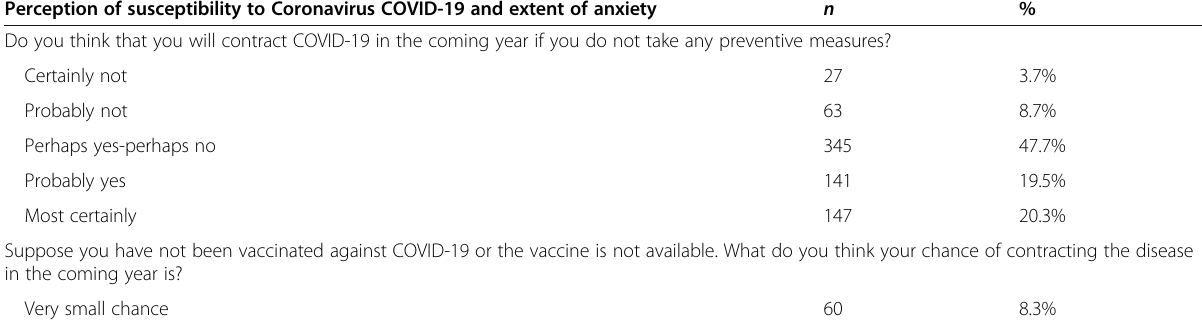
Table 5 Perceptions of susceptibility to COVID-19 and the extent of anxiety ( N = 723) Perception of susceptibility to Coronavirus COVID-19 and extent of anxiety n %